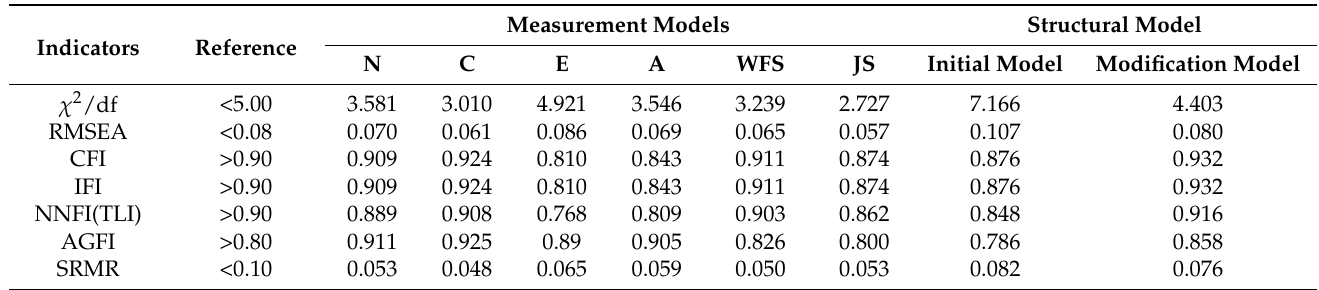
Table 1. Model fit